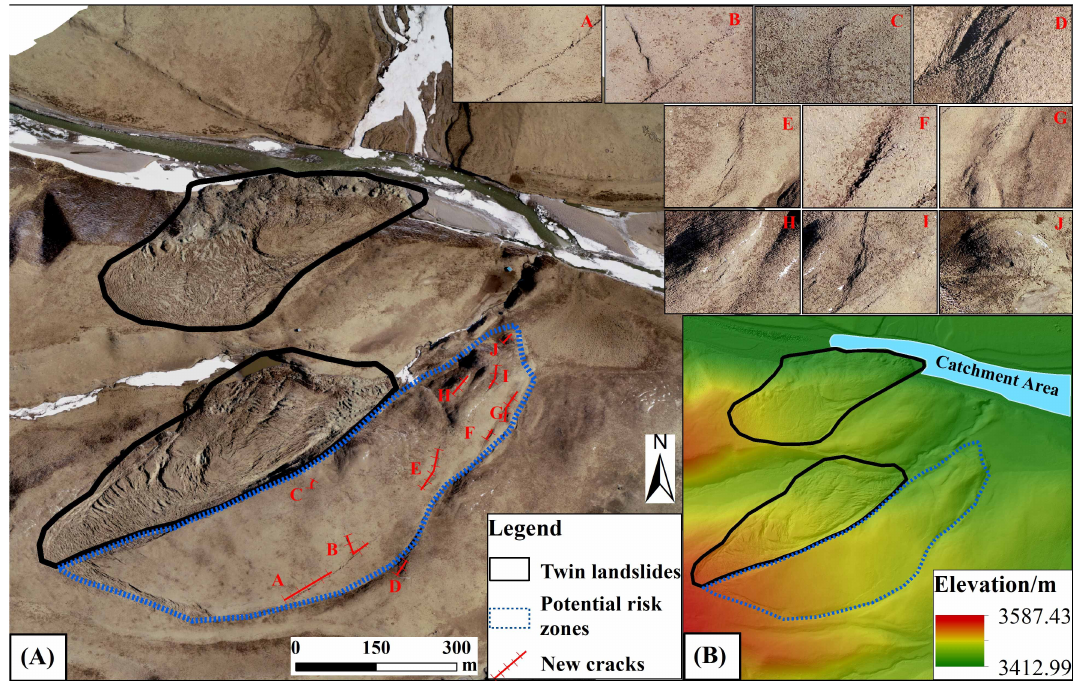
Figure 11. ( A ) The orthophoto map acquired by UAV in April 2021; the red lines denote the cracks. ( B ) The UAV-derived DEM